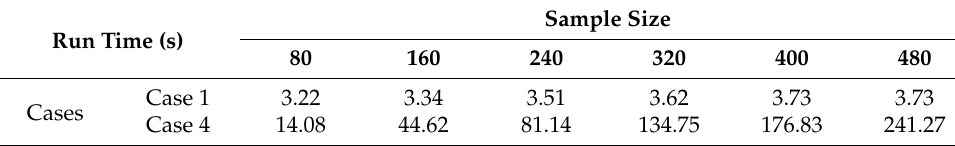
Table 2. Computational times of Case 1 and Case 4 with different sample sizes.